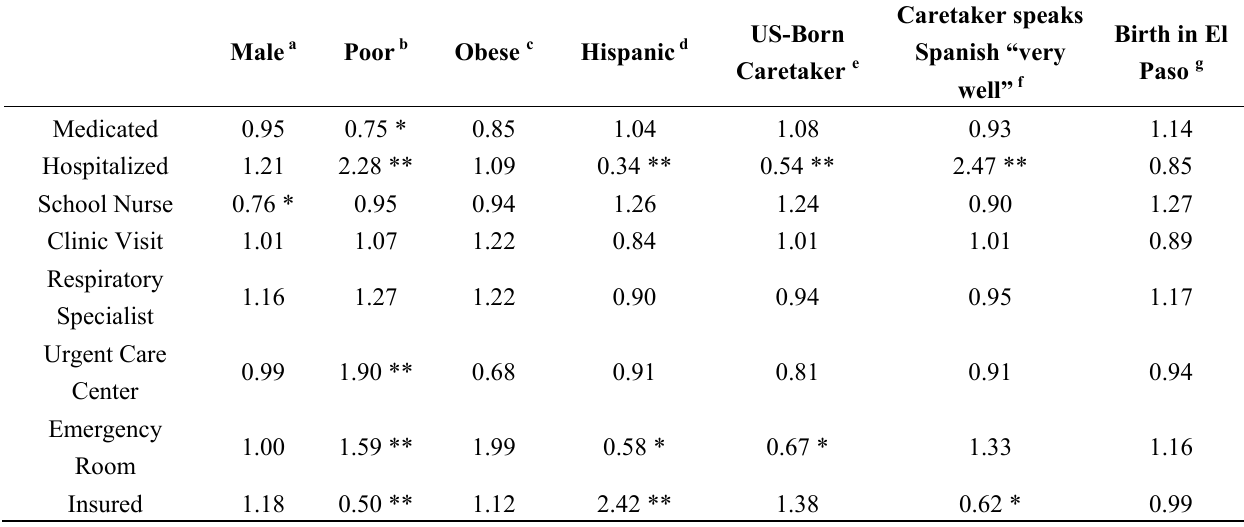
Table 5. Social disparities for access to care for children with asthma and/or wheezing: odds ratios and statistical